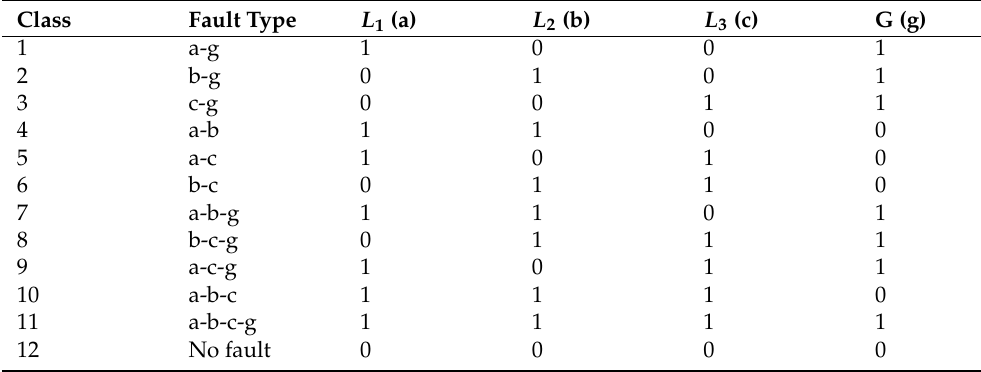
Table 3. Fault types in binary representation